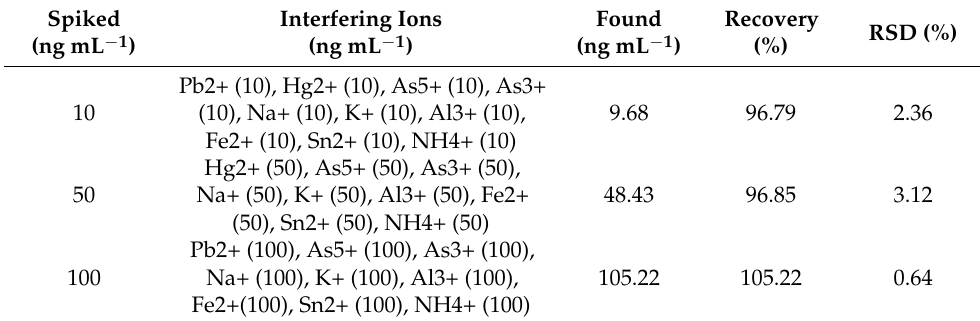
Table 2. Determination of Cd 2+ in artificial water samples (n ≥ 3).